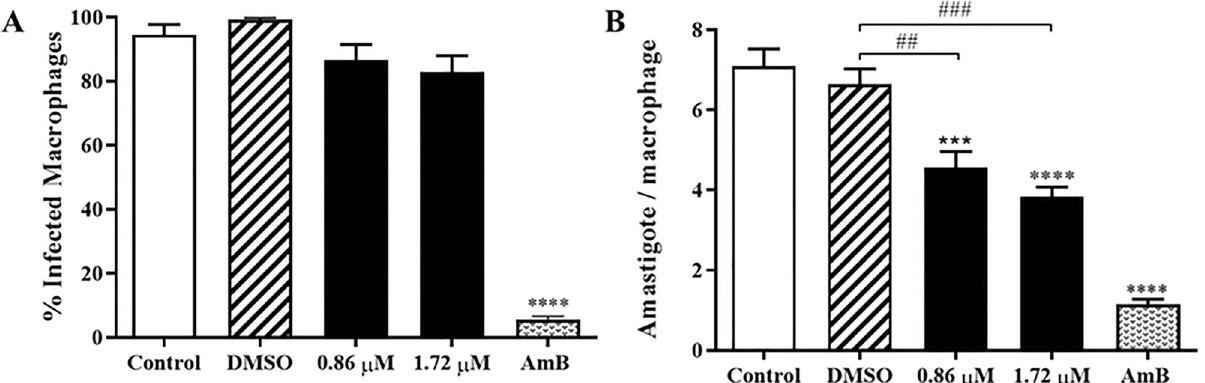
Figure 6. Infected macrophages by L. amazonensis treated with TMBP (0.86 µM and 1.72 µM). (A) Percentage of infected macrophages. (B) Evaluation of the numbers of amastigotes per macrophage. Negative control (RPMI 1640 medium), AmB as a positive control (1 µM), and 0.015% DMSO (diluent control). Values represent the mean ± SEM of three independent experiments performed in duplicate. Significant difference from the